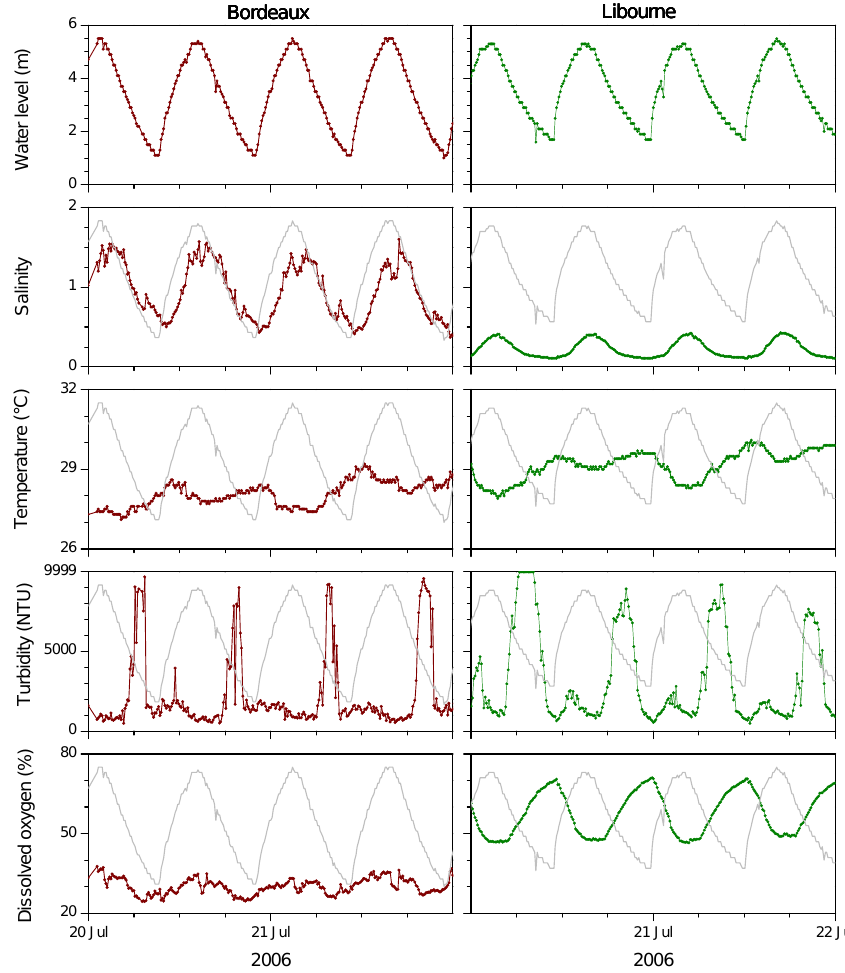
7 Fig. 3. Example of variations of water level (m), salinity, temperature ( ◦ C), turbidity (NTU) and dissolved oxygen (% of saturation) during consecutive semi-diurnal tidal cycles at stations Bordeaux (left) and Libourne (right) from 20 to 22 July 2006 (data every 10min). Corre- sponding water level curves (in light grey) are reported on each graph to highlight the relationship between the measured parameters and tidal